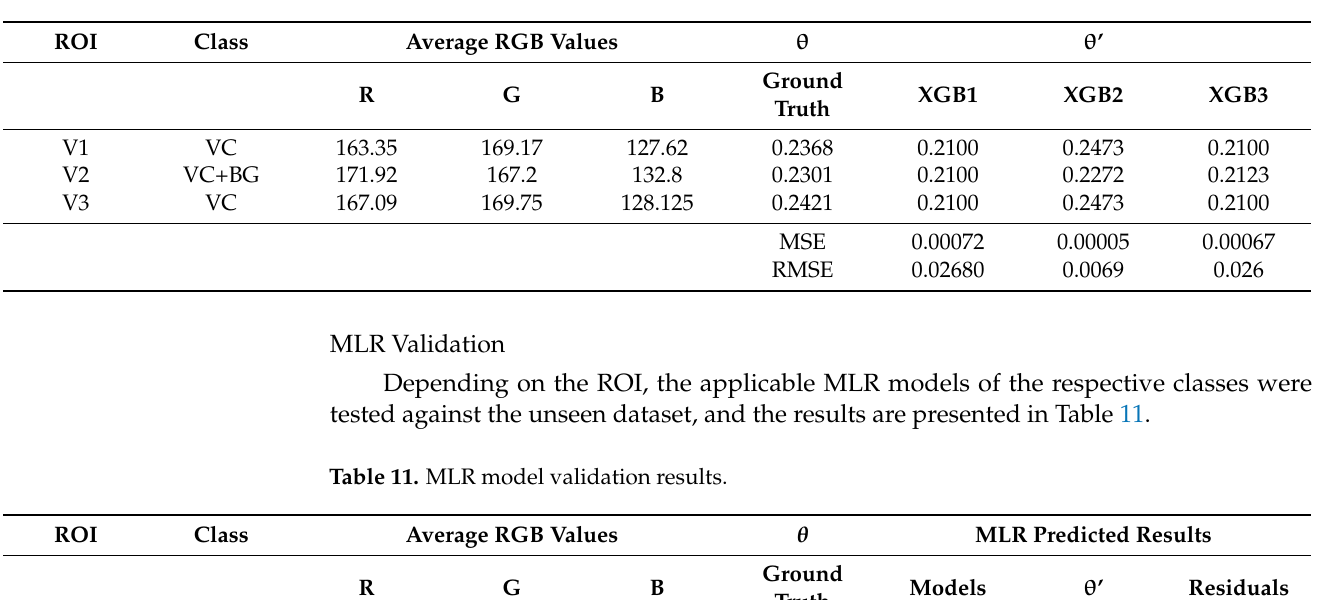
Table 10. XGB model validation results.